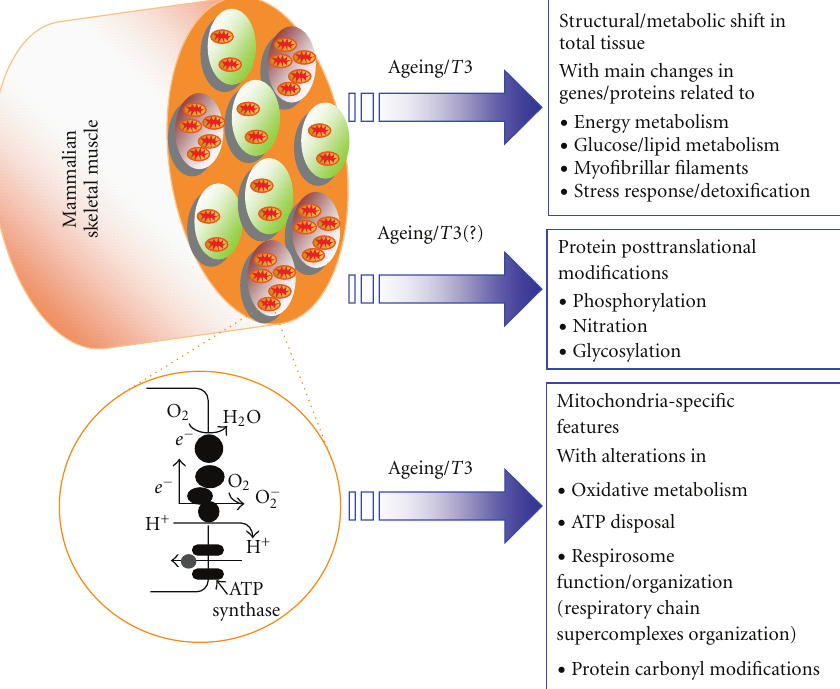
Figure 2: Integrated overview of the main ageing/T3-induced transcriptomic and proteomic alterations occurring in mammalian skeletal muscle. Schematic representation of the common events and mechanisms underlying the response of skeletal muscle to either ageing or T3 according to data obtained from cDNA microarray/proteomic-based studies in various mammalian models of ageing and thyroid state (mouse, rat, and human) (for details, see text and Tables 1, 2, 3, and